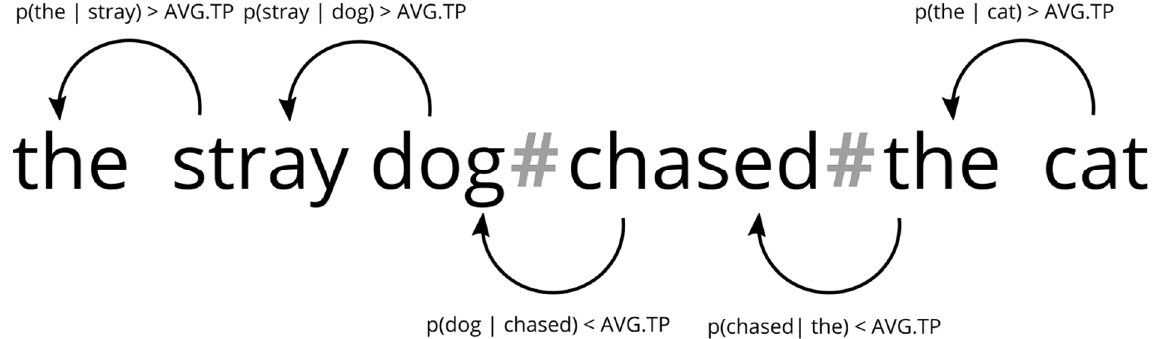
Figure 2. Simplified illustration of the chunk-based learner algorithm, freely adapted from McCauley and Christiansen (2019, p. 10). The # signs show where the algorithm posits a boundary between chunks because, in those positions, the backward transitional probability between the lexemes p(lexeme1|lexeme2) falls below the current average transitional probability (avg.tp).